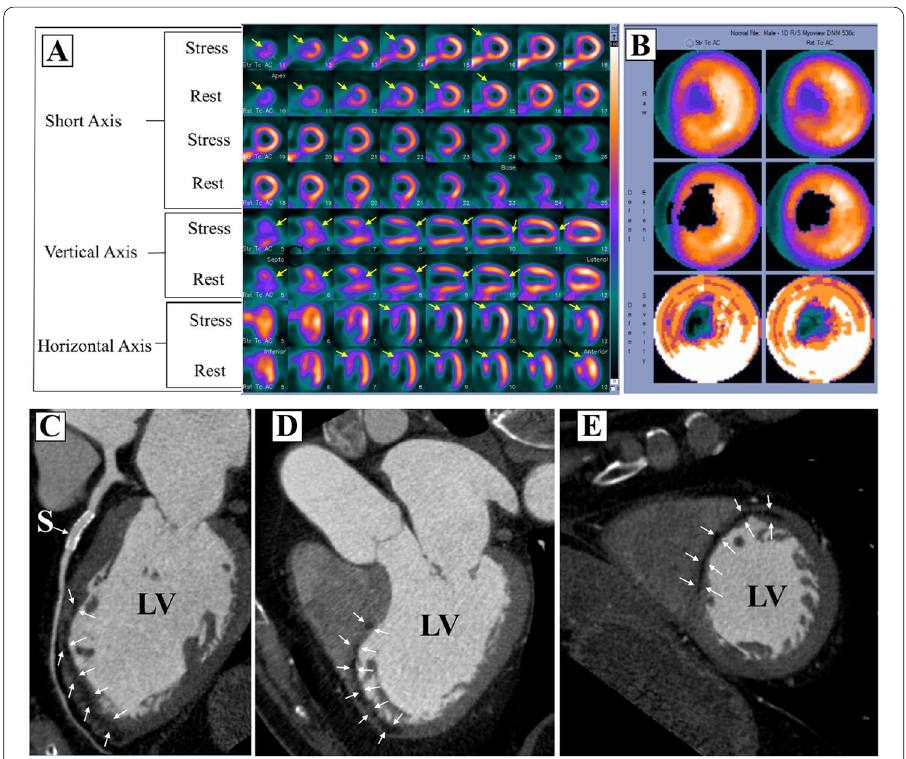
Fig. 5 A SPECT images, B polar maps at stress (upper panel) and rest (lower panel), C – E computed tomographic angiography images. LV, left ventricle; S,